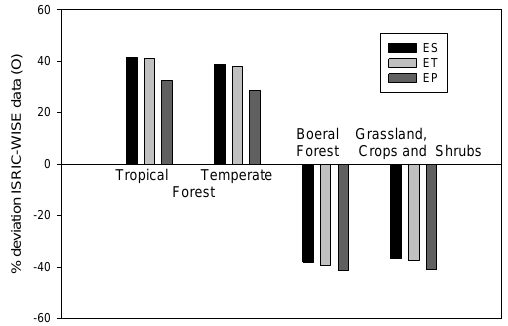
Figure 5. Deviation from ISRIC-WISE data (OBS) for the ES and the two modifications, ET and EP, grouped by ecoregions.